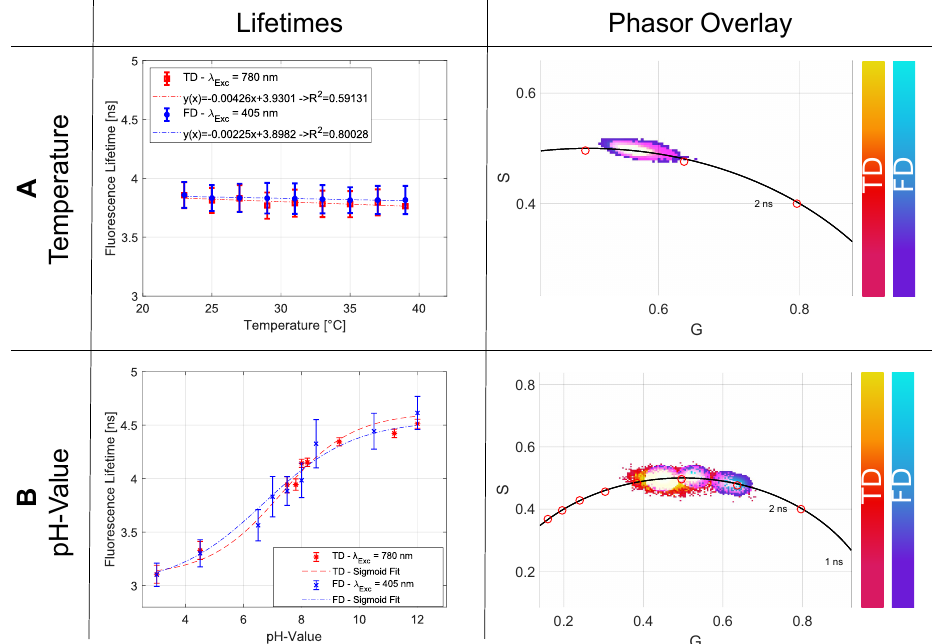
Figure 4. ( A ) shows the obtained results for the temperature dependency between 22–39 ◦ C and the slope of the fitted linear regression for fluorescein in ethanol. The overall lifetimes for the TD and FD are also represented in the phasor plot where a single point cloud indicates no significant lifetime change. In ( B ) the pH dependency for values between 3 and 12 are shown, which follow a sigmoid function.